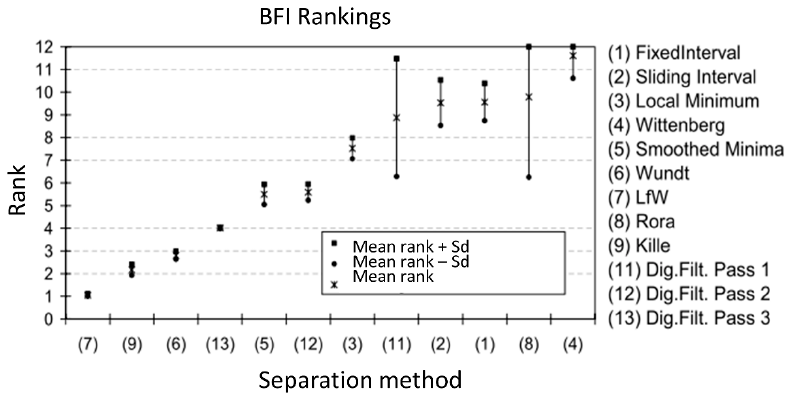
Figure 4. BFI Rankings for twelve baseflow separation methods, adapted from Rojanschi [51].